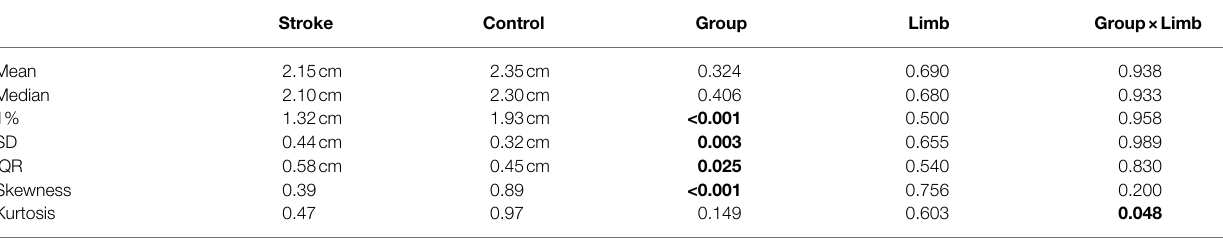
TABLE 1 | MFC characteristics of Post-stroke and Control